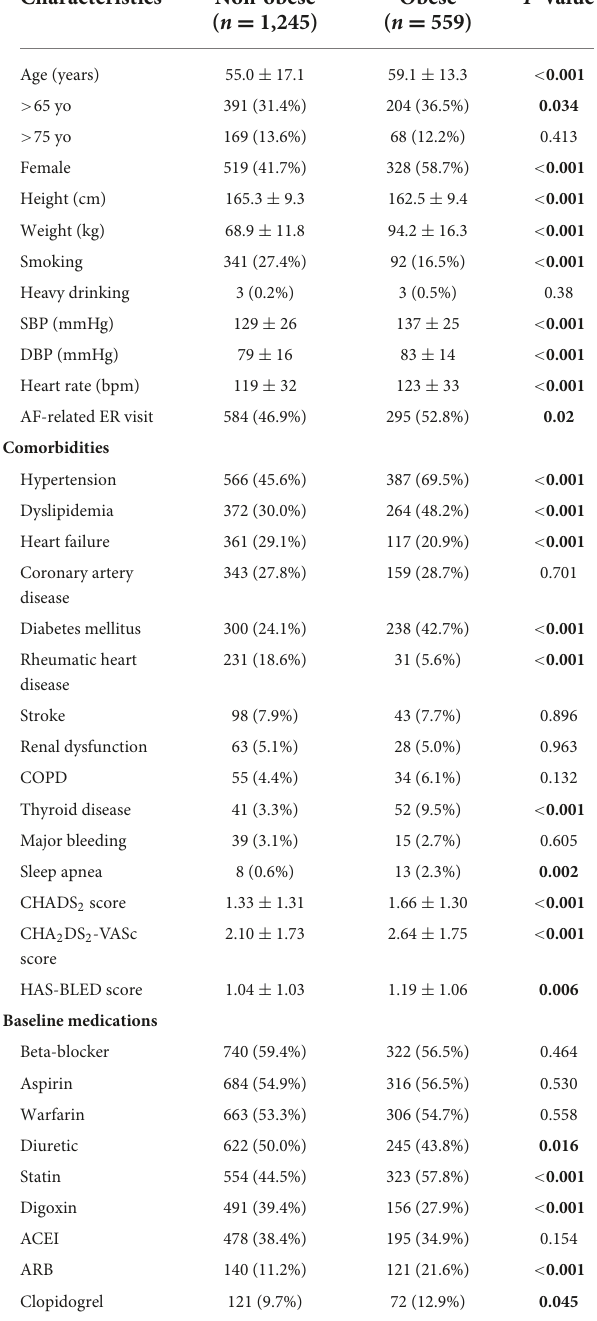
TABLE 1 Baseline characteristics of obese and non-obese patients with atrial fibrillation.